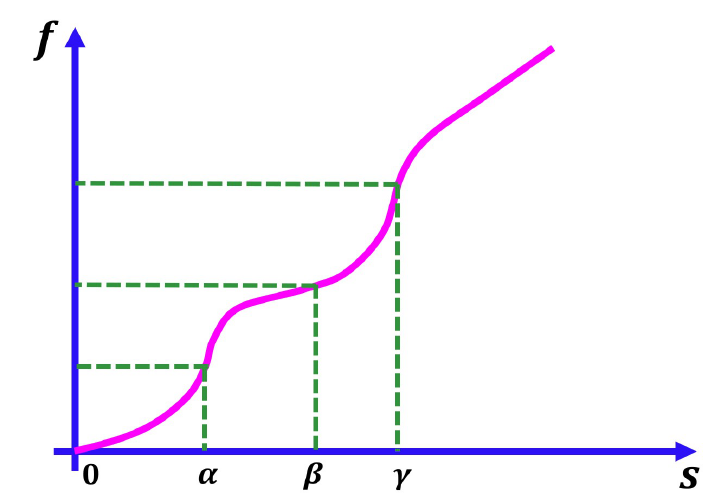
Fig. 4: Shape of f producing